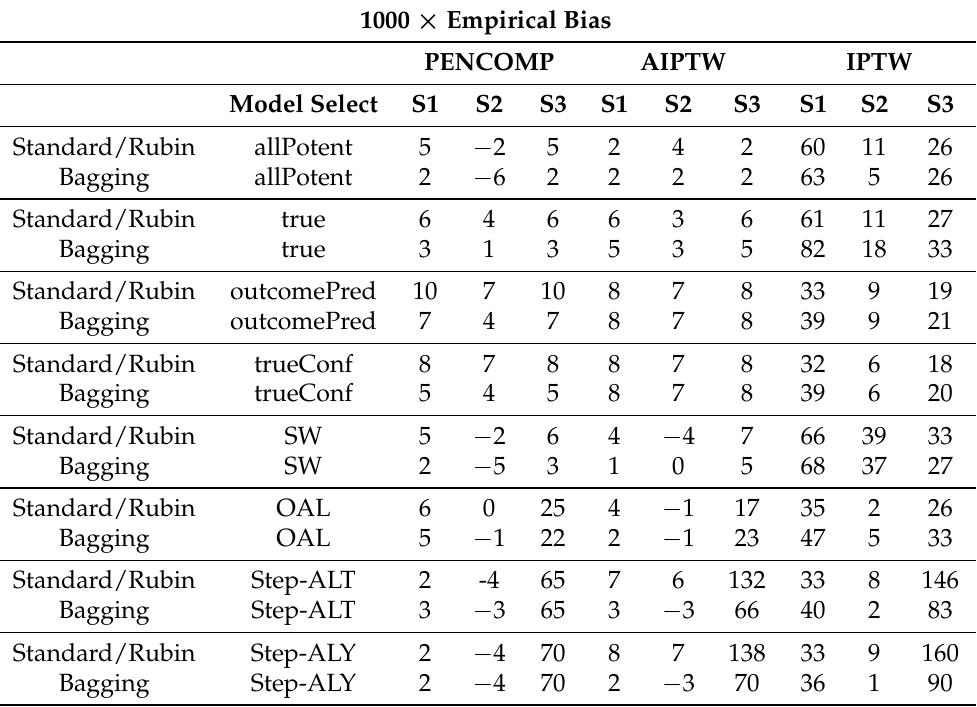
Table A1. 1000 × empirical bias with sample size of 200. The treatment effects η = 2. S1, S2, and S3 denote scenario 1, 2, and 3, respectively.